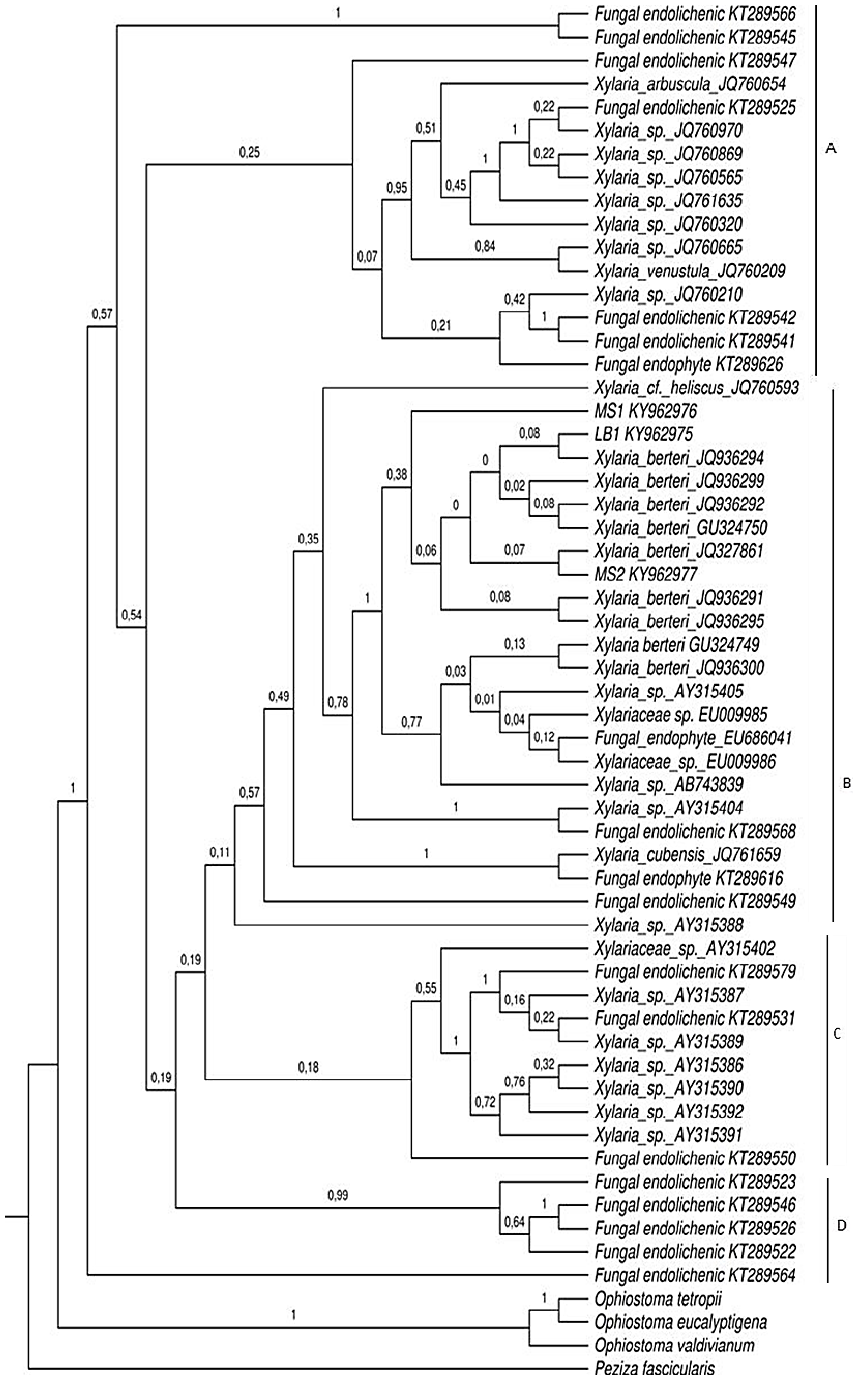
Figure 2. Phylogenetic relationships among endolichenic fungi isolated from Cladonia curta and sequences of endophytic fungi from plants (lichens [1,9], liverworts [43] and BLASTn [44]). MS1, MS2 and LB1 corresponding to sequences obtained in the present study. The phylogenetic tree inferred by maximum likelihood based on one-locus ITS region of rDNA dataset. The numbers at each internode indicates bootstrap support values. Three species of Ophiostoma ( O. valdivianum , O. eucalyptigena and O. tetropii ) and Peziza fascicularis were used as outgroup.